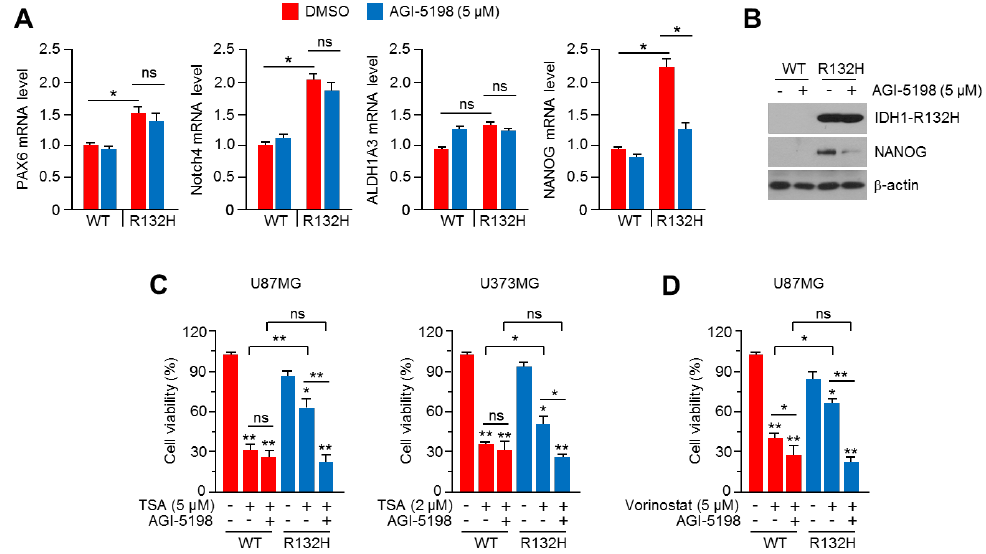
Figure 7. The beneficial e ff ect of AGI-5198 on overcoming to HDACi resistance in IDH1 R132H overexpressing U87MG and U373MG glioblastoma cells. ( A ) IDH1-WT or IDH1 R132H expressing cells were incubated in the absence or presence of 5 µ M of AGI-5198 for 24 h. Gene expression was measured by using qRT-PCR. The values represent the mean ± SD of three independent experiments performed in duplicate; * p < 0.05. ( B ) Protein levels were measured by using western blotting. ( C ) IDH1-WT or IDH1 R132H expressing U87MG or U373MG cells were incubated with or without TSA or AGI-5198 (5 µ M) for 48 h, as indicated. Cell viability was analyzed by using crystal violet staining. The values represent the mean ± SD of three independent experiments performed in duplicate; * p < 0.05 and ** p < 0.01. ( D ) IDH1-WT or IDH1 R132H expressing U87MG cells were incubated with or without vorinostat (5 µ M) or AGI-5198 (5 µ M) for 48 h, as indicated. Cell viability was analyzed by using crystal violet staining. The values represent the mean ± SD of three independent experiments performed in duplicate; * p < 0.05 and ** p < 0.01.